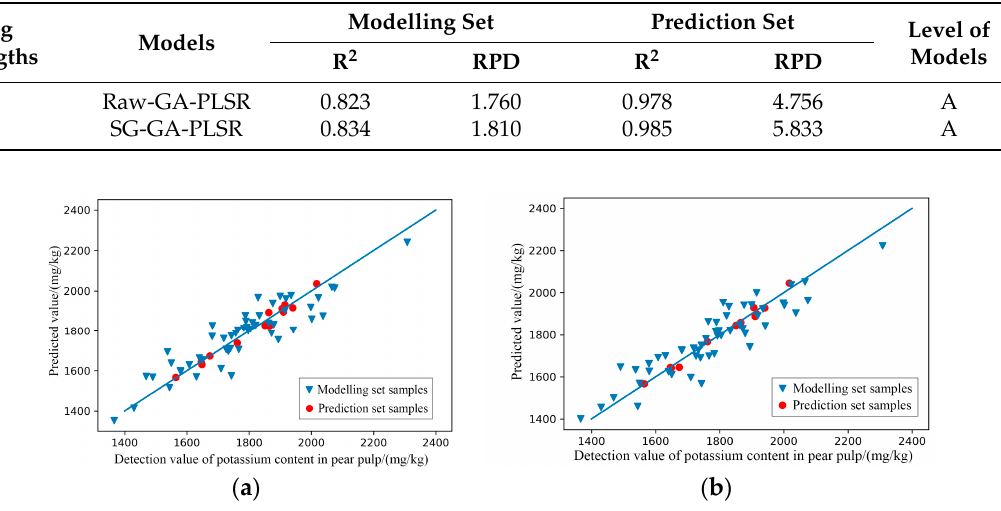
Figure 11. Scatter plots of models’ prediction results of the content of potassium in pear pulp